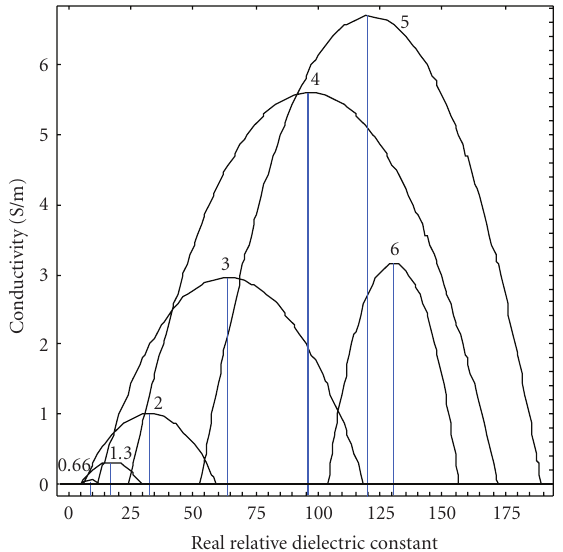
Figure 4: Contours of constant reflection magnitude for lossless bolus matching to skin-covered fatty breast tissue. A perfect match occurs at 6.45GHz for a pure dielectric bolus with dielectric con- stant of 135. The worst coupling occurs at 2.67 GHz, with reflection coe ffi cient of 0.34 for the best choice dielectric constan ε (cid:4) = 30 . 4. regions of Figure 4 correspond to | Γ | > 0 . 4. Both the mini- mum reflection magnitudes and their variation with dielec- tric constant are much greater than those for frequencies above the critical value, found numerically to be 6.45 GHz.